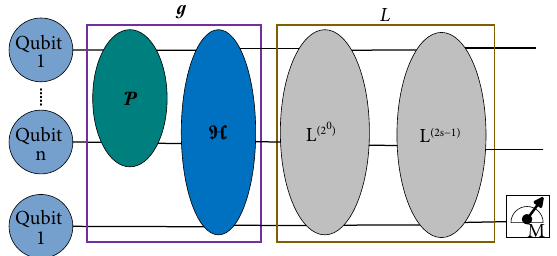
Fig. 4 Schematic of quantum circuits of the quantum estimation algo-